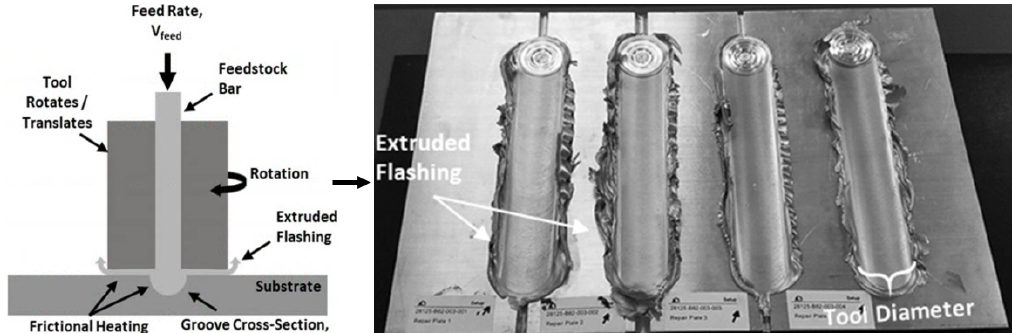
Figure 17. The schematic and the repaired result of AA6061-T651 [36].